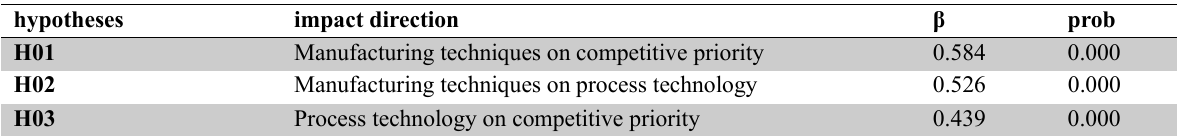
Standardized total